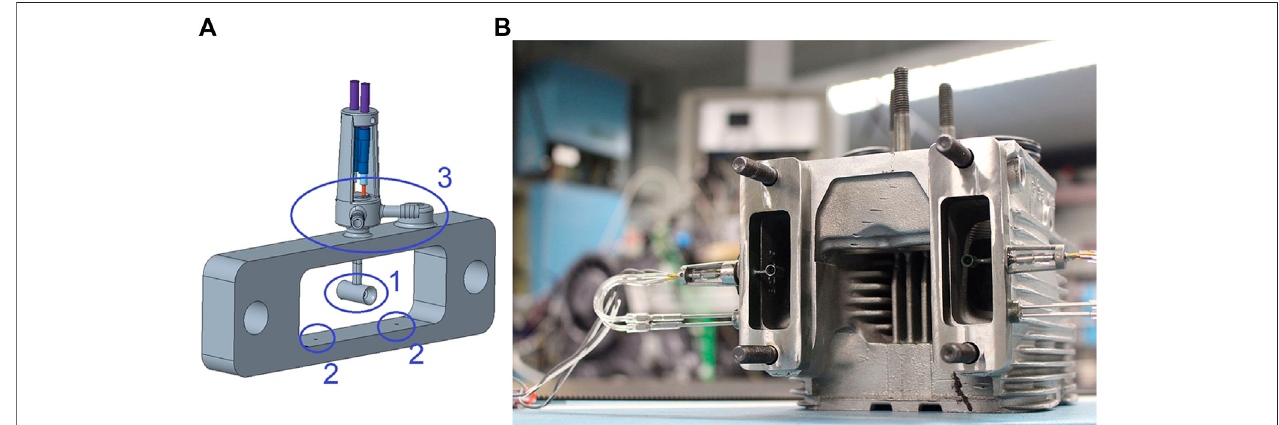
FIGURE 2 | (A) 3D-CAD model of a Vecto fl ow probe, (B) Probes mounted on the cylinder